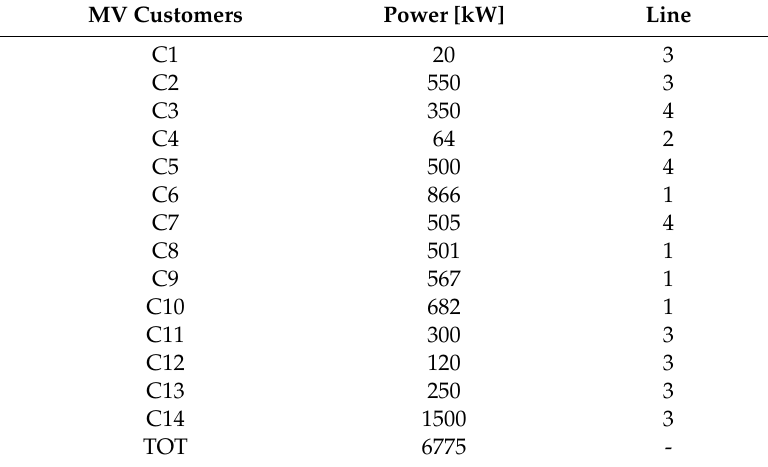
Table 3. MV passive customers.